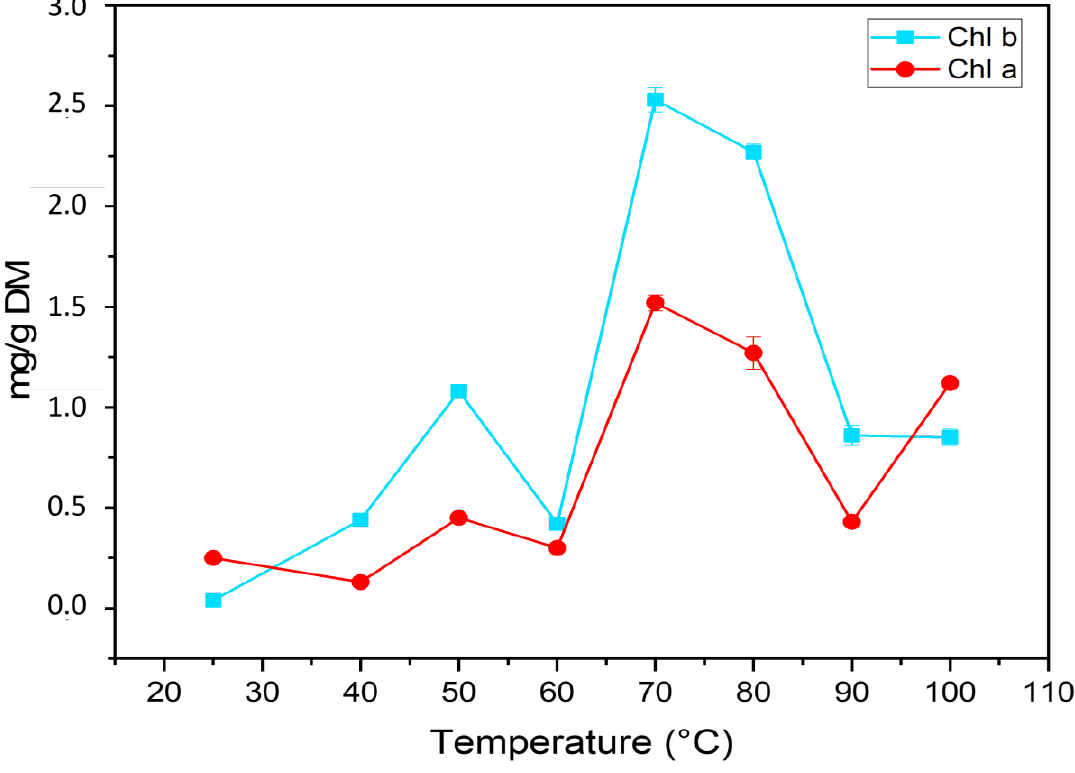
Figure 2. Impact of temperature on the content of chlorophylls a and b in argan pulp powder (mg/g dry